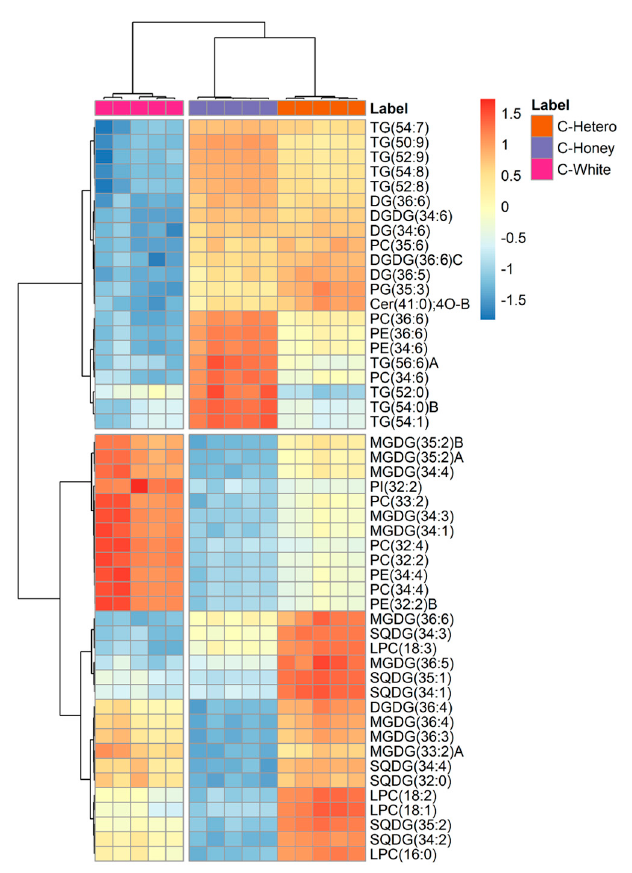
Figure 5. Two − dimensional hierarchical clustering analysis and heatmap containing the top 50 most discriminating lipids (One-Way ANOVA, q < 0.05) identified in 3 strains of Chlorella vulgaris (C − Hetero, C − Honey, and C − White). Relative abundance levels are indicated on the colour scale, with numbers indicating the fold difference from the mean. The clustering of sample groups is represented by the dendrogram at the top. The clustering of individual lipid species considering their similarity in relative abundance is represented by the dendrogram on the left. Letters A, B, and C refer to different combinations of esterified fatty acids within the same molecular species, which can be found in Supplementary Table S1. Abbreviations: DGDG, digalactosyldiacylglycerol; MGDG, monogalactosyldiacylglycerol; SQDG, sulfoquinovosyldiacylglycerol; PC, phosphatidyl- choline; LPC, lysophosphatidylcholine; PE, phosphatidylethanolamine; PG, phosphatidylglycerol; PI, phosphatidylinositol; Cer, ceramide; DG, diacylglycerols; TG,